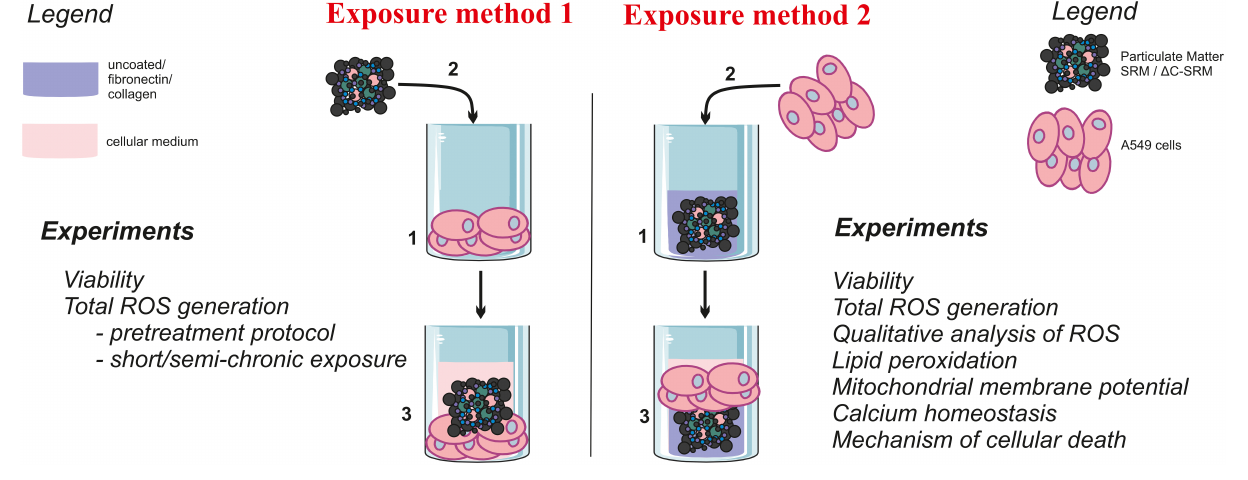
SCHEME 1 | The graphical representation of the used exposure methods and performed